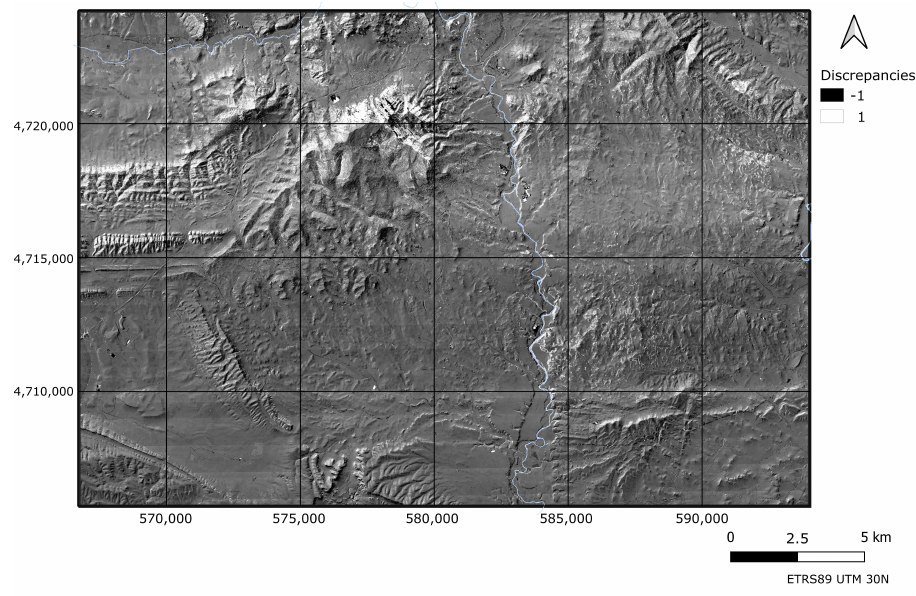
Figure 3. Discrepancies model (error model) of the Allo zone (DEM05-DEM02).